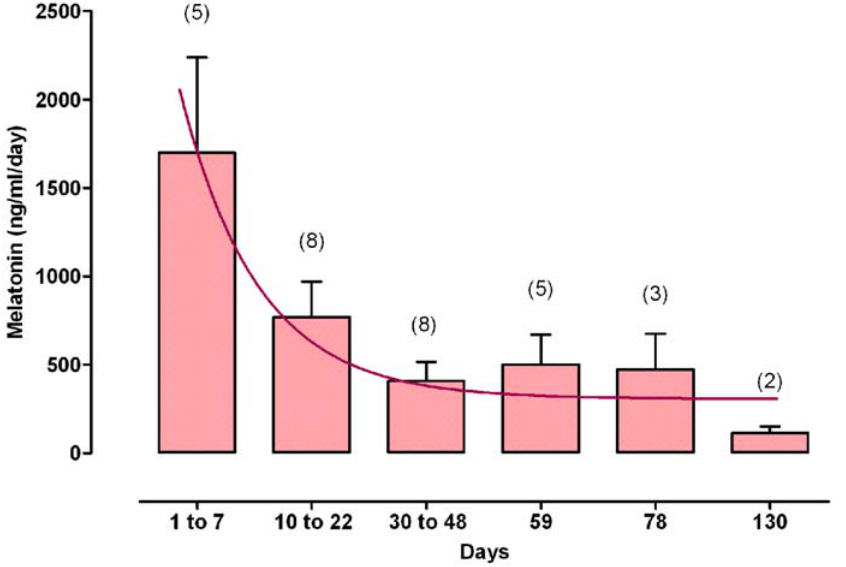
Figure 2. 24 h Melatonin release by the implant. Melatonin implants were individually immersed in 1 mL physiological buffer renewed every 24 hours for up to 130 days. Melatonin concentration measured in the physiological serum are the Mean 6 SEM (n is indicated under brackets). The data fitted an exponential decay.